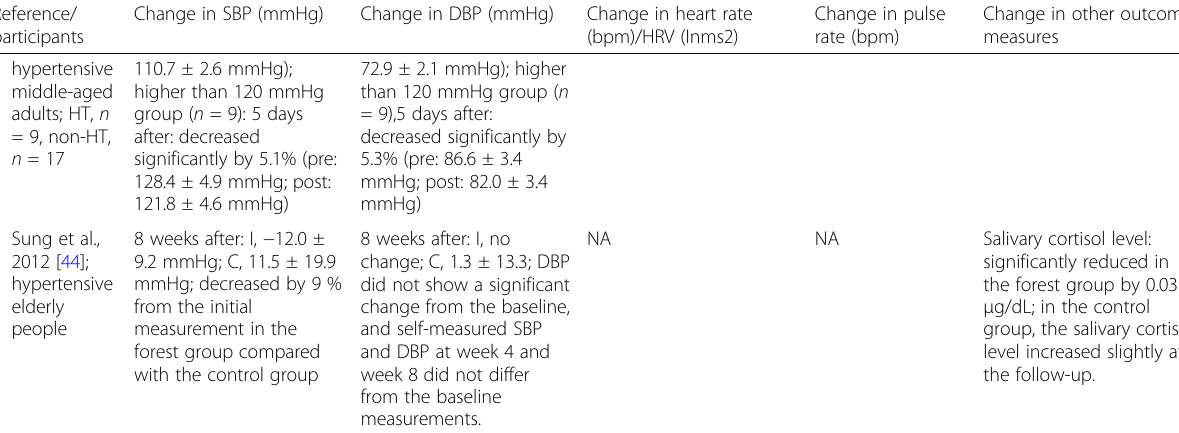
Change in pulse Change in other outcome (bpm)/HRV (Inms2) rate (bpm) measures